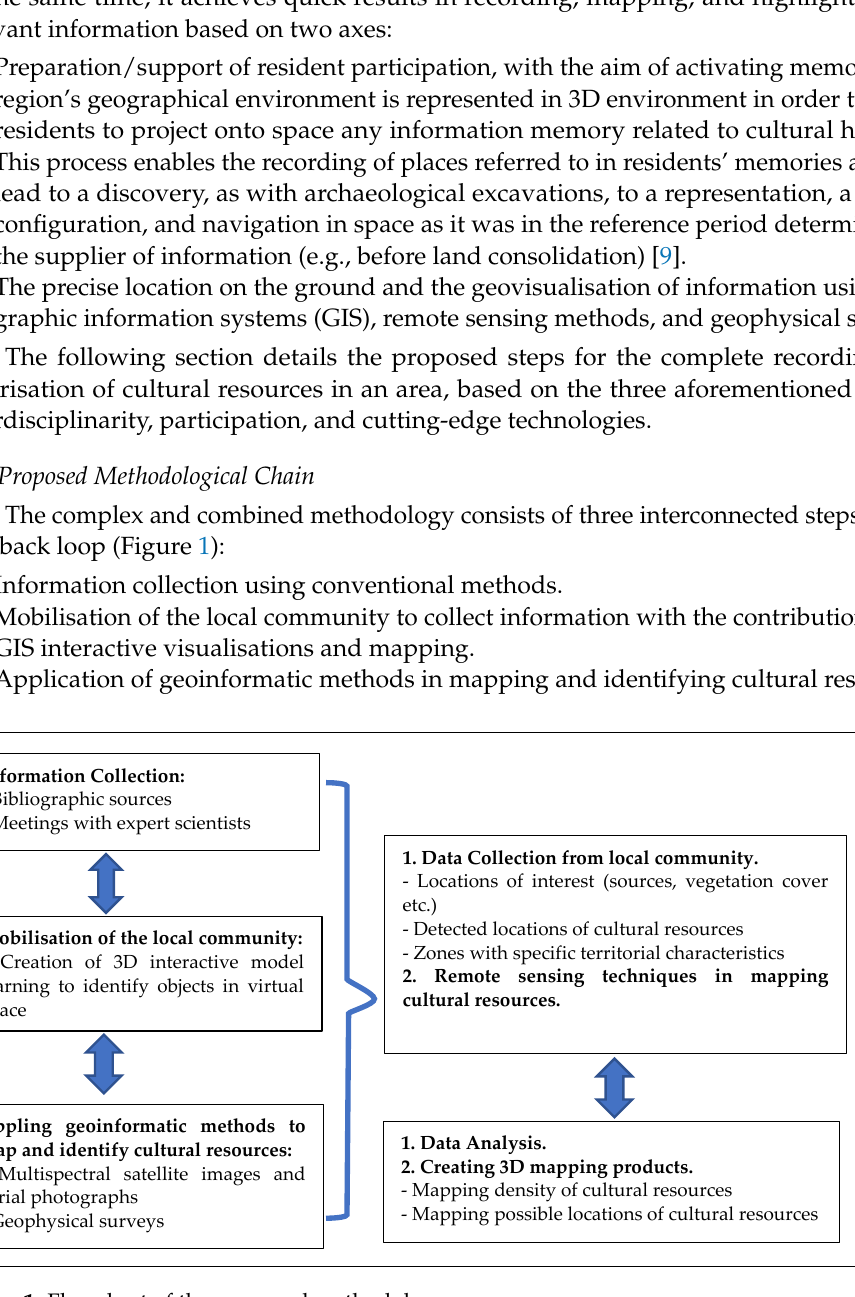
Figure 1. Flowchart of the proposed methodology.